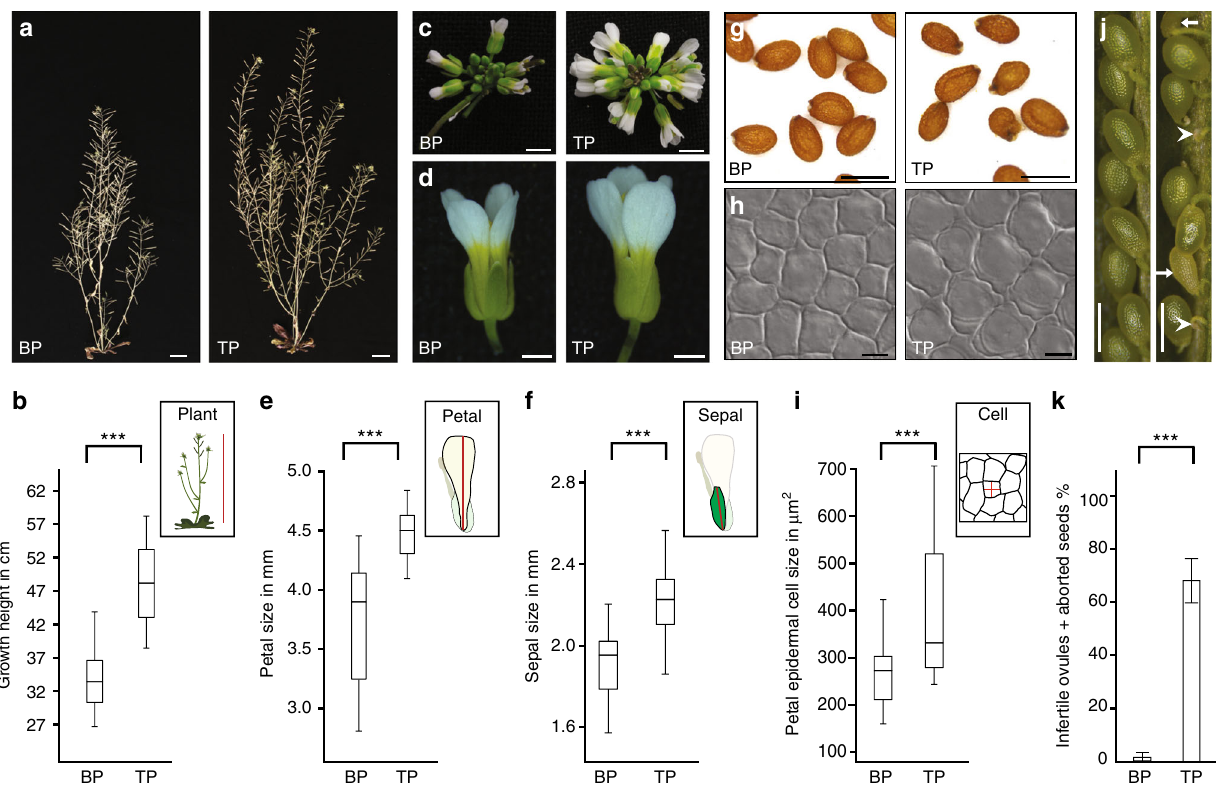
Fig. 3 Polyspermy-induced triploid plants are taller and produce bigger organs than plants originating from a regular fertilization mode. a , b Growth height comparison between biparental diploid plants (BP; n = 19), and herbicide-resistant triploid triparental plants (TP; n = 7). c , d In fl orescence and fl ower of BP and TP plants. e Petal size of BP ( n = 68) and TP plants ( n = 104). f Sepal size of BP ( n = 89) and TP plants ( n = 107). g Seed morphology of BP and TP plants. h , i Size of petal epidermis cells in BP ( n = 58) and TP plants ( n = 93). j , k Silique analysis of 2n BP ( n = 19) and 3n TP ( n = 39) plants. Siliques are showing dark green seeds, sterile ovules (white arrowhead) and abnormal seeds (white arrow). k Graph shows mean ± s.d. P values (*** p < 0.001) report signi fi cance by t-test. Box plots show median, quartiles, maximum and minimum. Scale bars, 2 cm a , 2 mm c , 1 mm d , 0.5 mm g , 5 µ m h , 0.5 mm